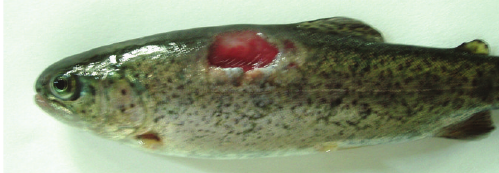
Figure 2: Skin ulcer penetrating deep into the muscle in trout Sc challenged with A. hydrophila